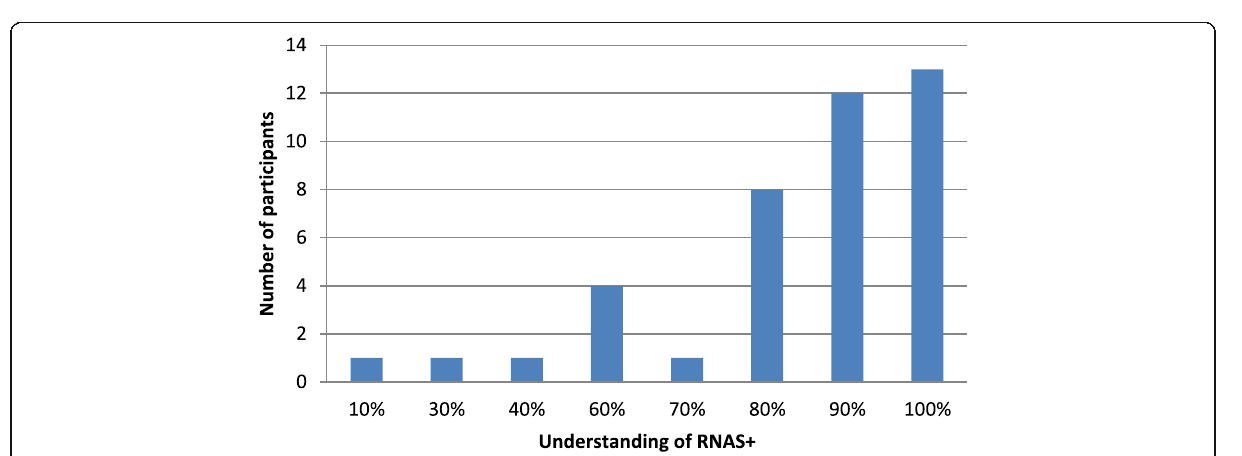
Fig. 1 The participants understanding of RNAS